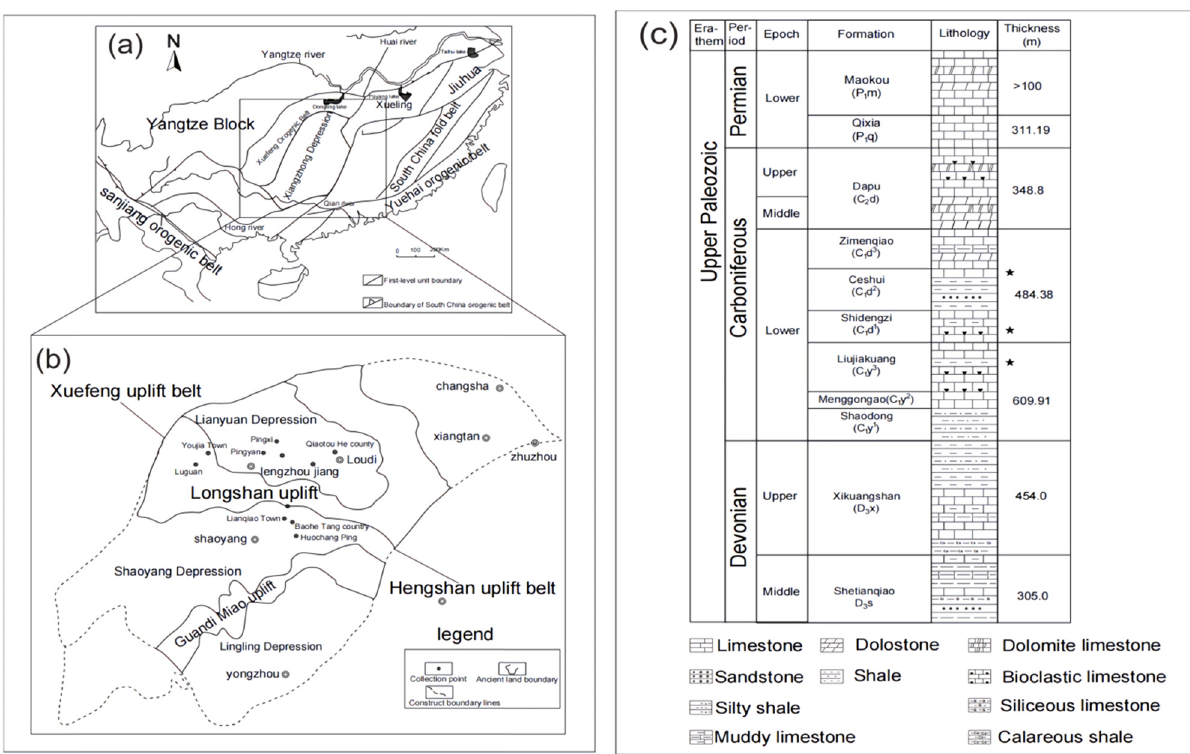
Figure 1: ( a ) Outline map of China showing position of the central Hunan Basin and study area; ( b ) regional geological map of the study area and sampling locations; and ( c ) generalized stratigraphic column of Carboniferous Permian strata of the study area with stars marking position of the target